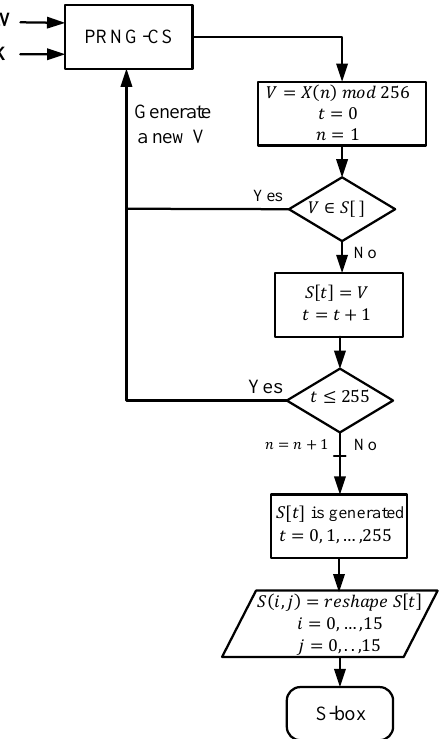
Figure 4. Block diagram of the proposed chaos-based 8 × 8 S-box